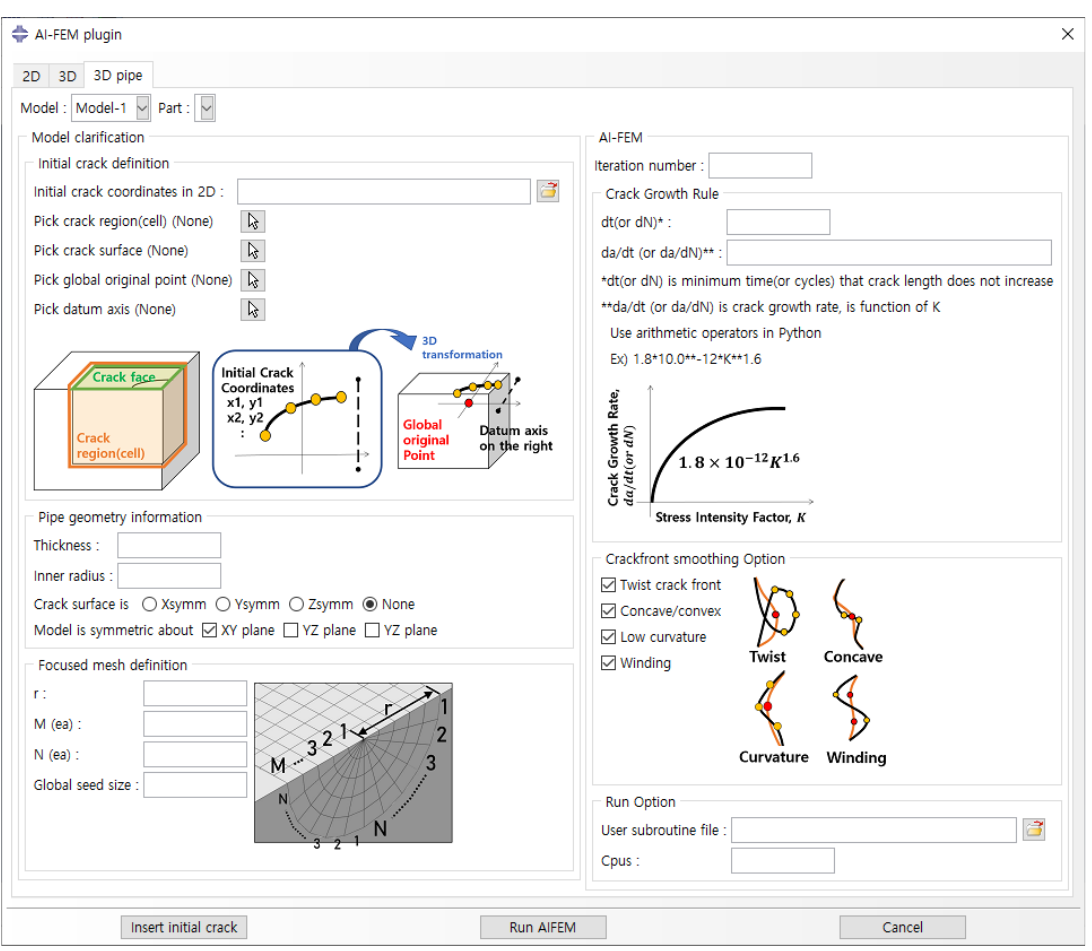
Figure 8. The graphical user interface of AI-FEM.